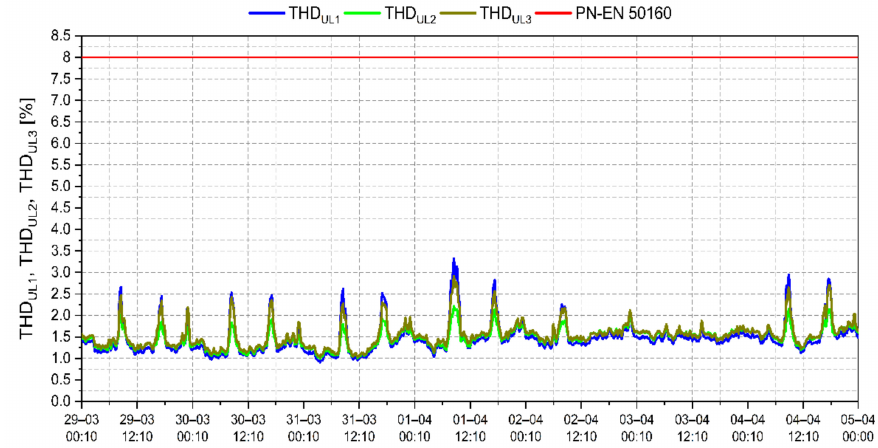
Figure 8. Total harmonic distortion of voltage variation during the measurement week.